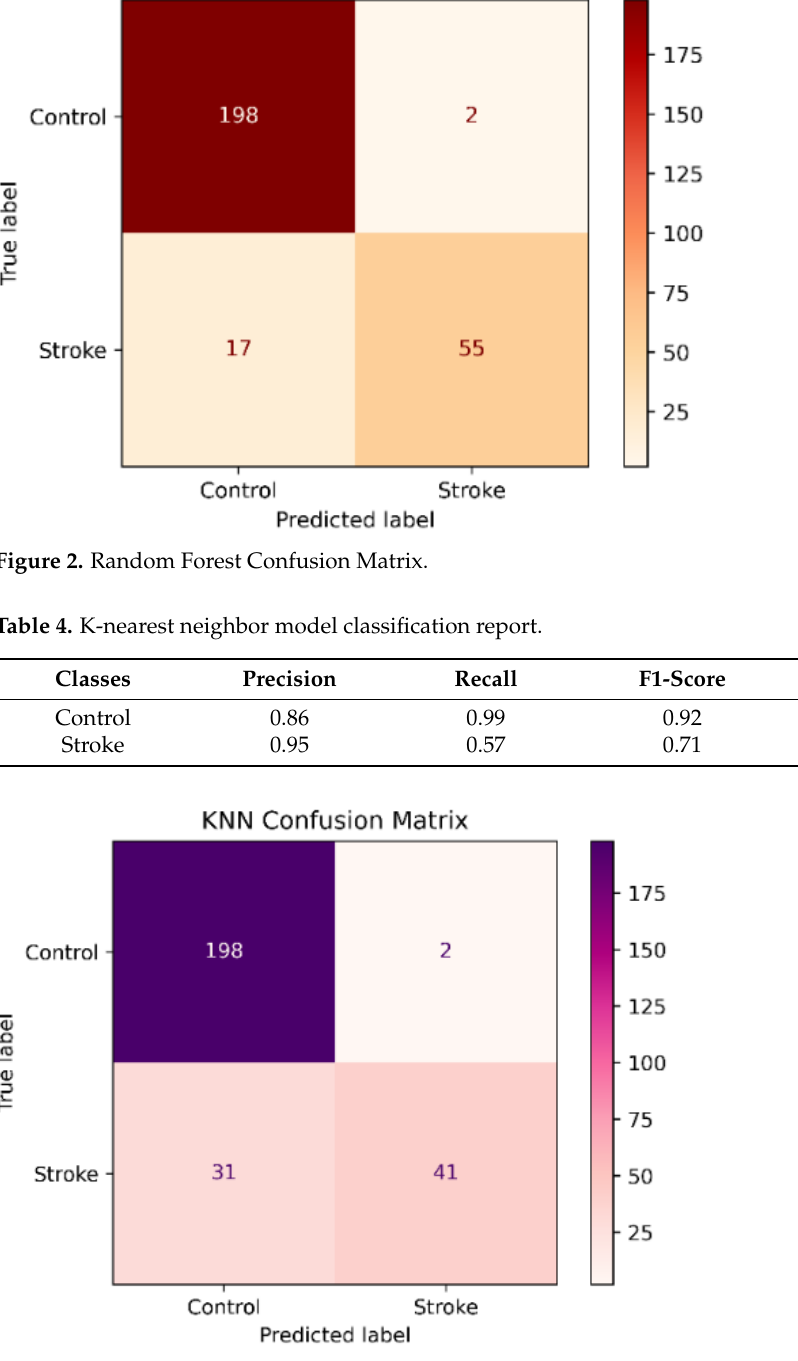
Figure 3. K-nearest Neighbor Confusion Matrix.